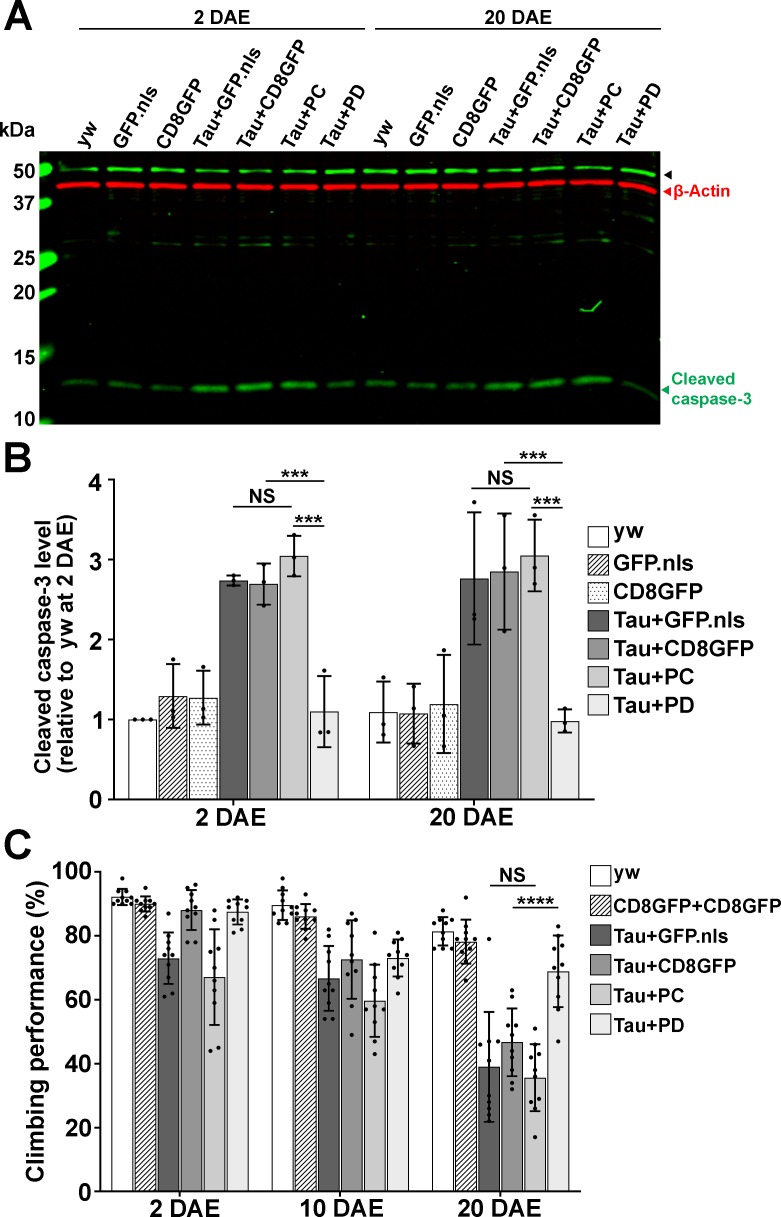
Drosophila Nmnat PD, not PC, protects against Tau-induced brain apoptosis and locomotor defects.A Western blot analysis of proteins extracted from 2 and 20 DAE yw fly heads or fly heads with neuronal expression of GFP.nls, CD8GFP, TauR406W+GFP.nls, TauR406W+CD8GFP, TauR406W+PC, or TauR406W+PD by elav-GAL4 using an antibody against cleaved caspase-3. β-actin was used as an internal control. B Quantification of the cleaved caspase-3 levels in A. Fold change of P12 was normalized to 2 DAE yw flies. n = 3. Data are presented as mean ± s.d., with n = 3. One-way ANOVA with Bonferroni’s post hoc test. ***p<0.001, NS: not significant. C Climbing performance of yw flies or flies with neuronal expression of CD8GFP+CD8GFP, TauR406W+GFP.nls, TauR406W+CD8GFP, TauR406W+PC, and TauR406W+PD by elav-GAL4 at 2, 10, and 20 DAE. Ten groups (10 flies in each, total 100 flies) of each genotype were tested. Data are presented as mean ± s.d., with n = 10. One-way ANOVA with Bonferroni’s post hoc test. ****p<0.0001, NS: not significant.